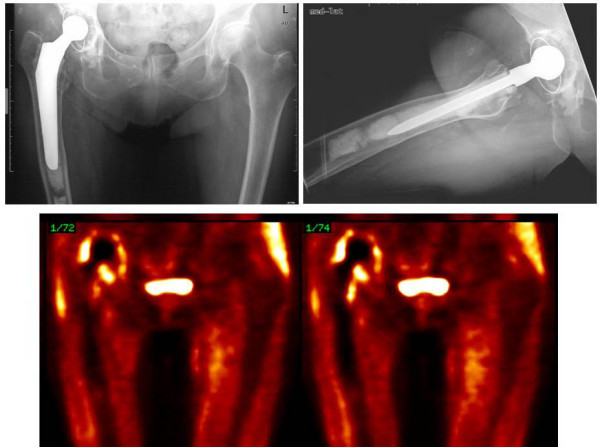
18F-FDG-PET showed periacetabular uptake (pattern 4a) as evidence of loosening of the cup confirmed by surgery. A bacterial infection was excluded. Loosening of the shaft within the cement bed is not adequately depicted by 18F-FDG-PET.